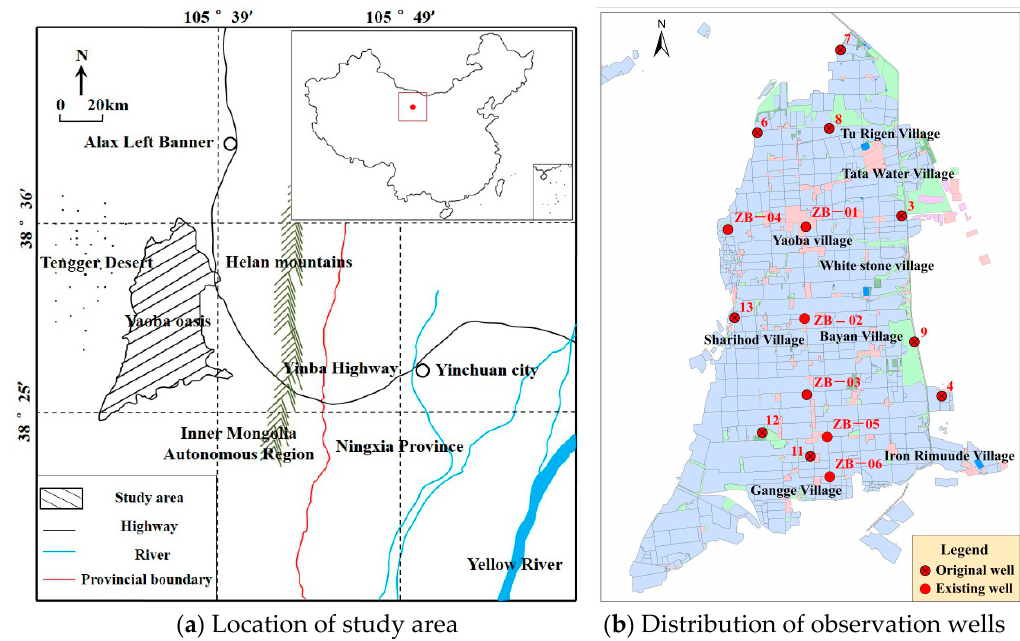
Figure 1. Map of Yaoba Oasis, Inner Mongolia Autonomous Region, China.